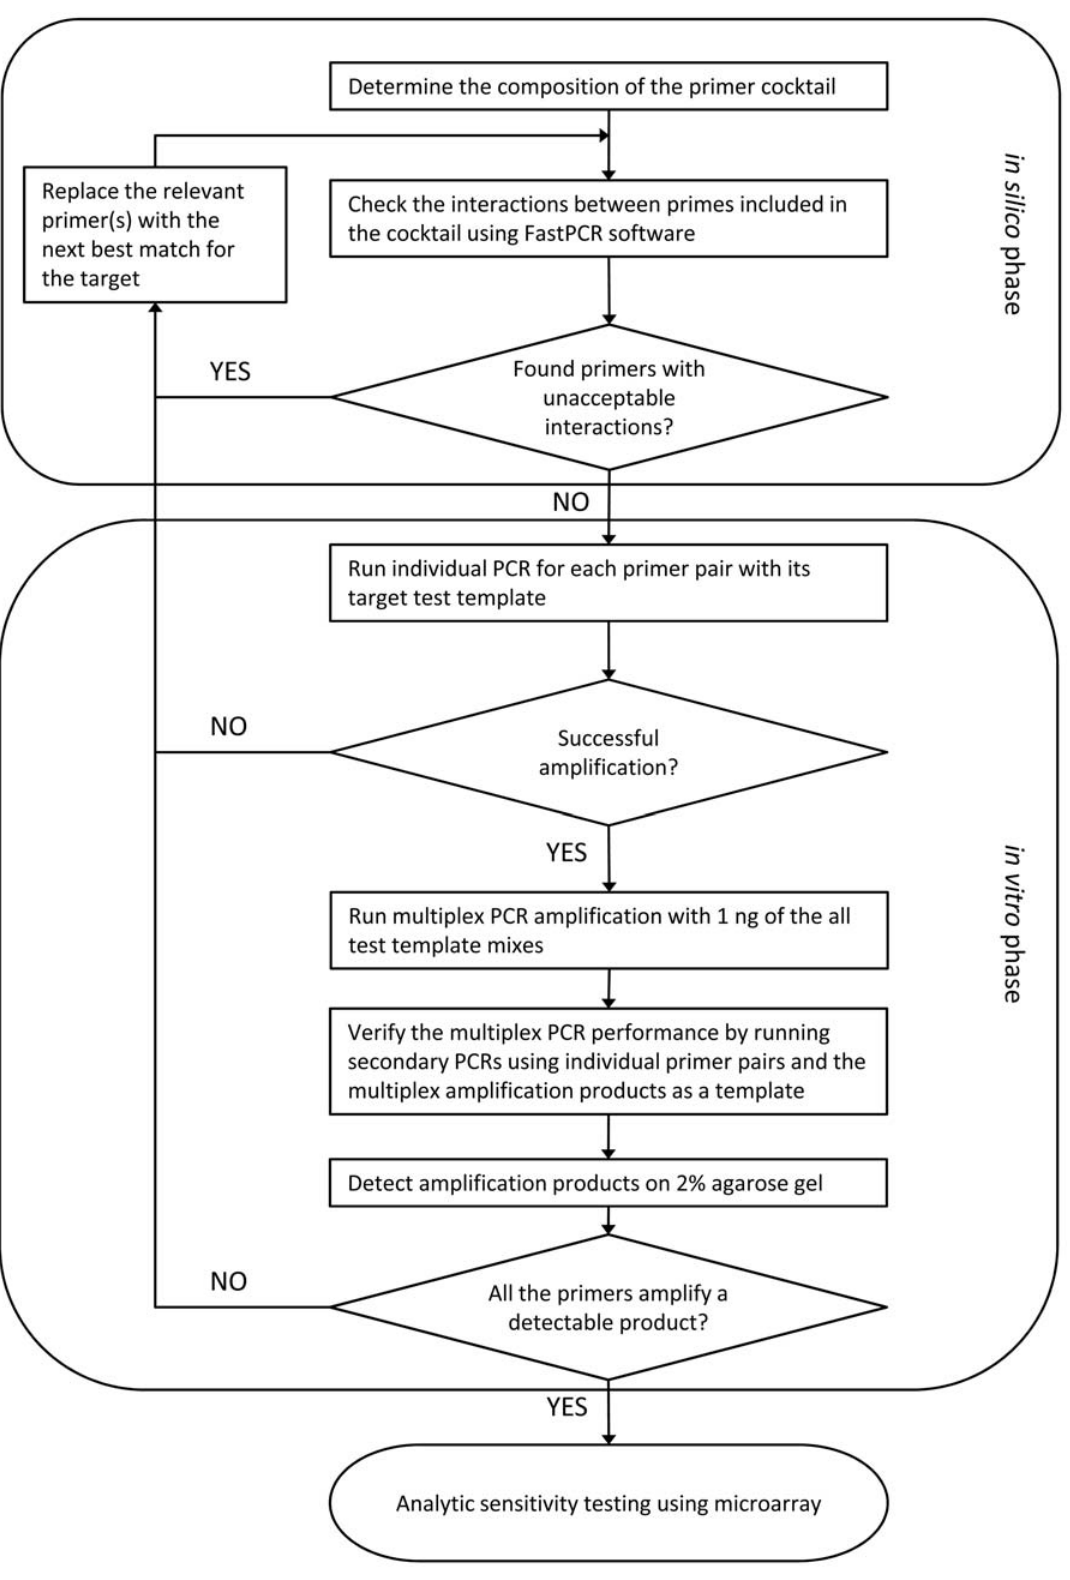
Figure 2. Procedure of optimization of primer cocktails. The diagram illustrates the procedure used to optimize the compositions of primer cocktails used for target amplification. The procedure consists of two stages. First stage was conducted using software for analysis of primer interactions and the second stage was carried out in vitro by testing of the performance of cocktails in multiplex PCR reactions.